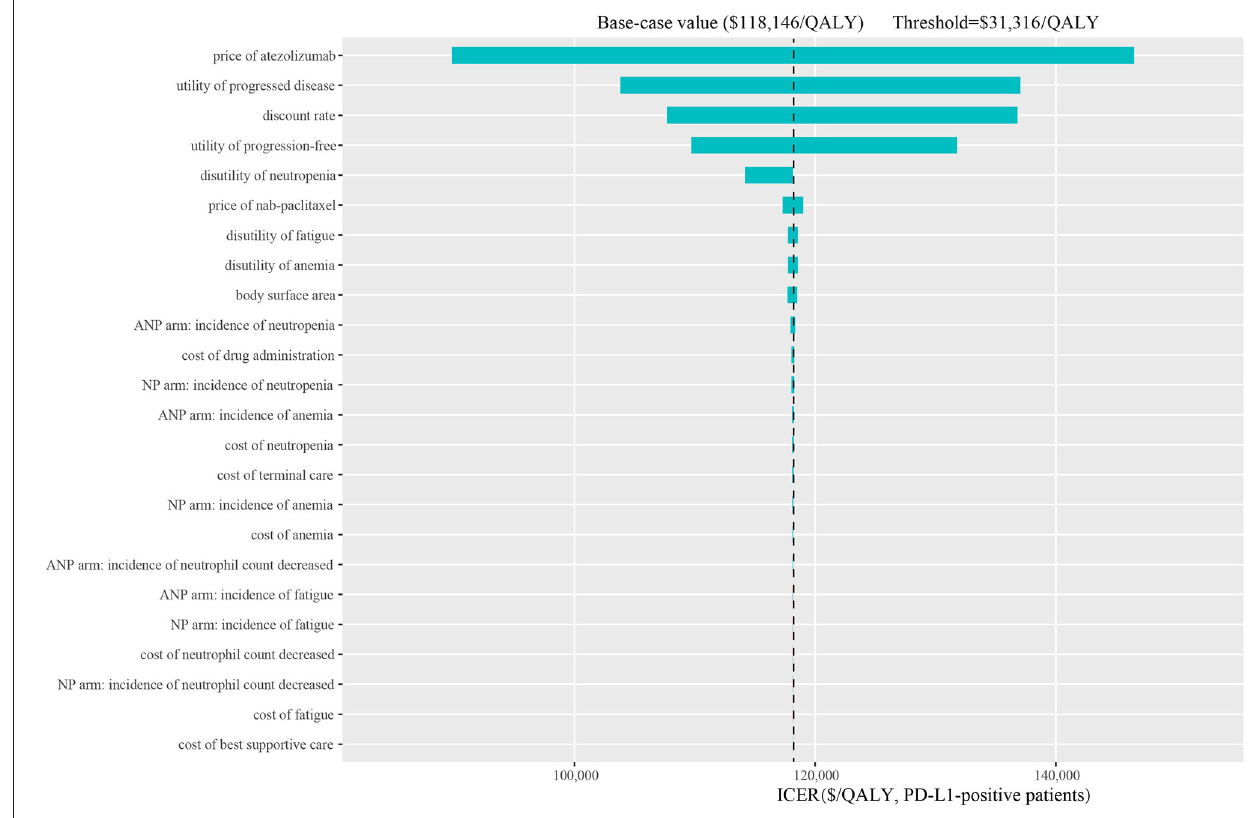
FIGURE 3 | Tornado diagram of one-way sensitivity analysis in the PD-L1-positive patients. ITT, intention-to-treat; PD-L1, programmed death ligand-1; QALY, quality-adjusted life-year; ICER, incremental cost-effectiveness ratio; ANP, atezolizumab plus nab-paclitaxel; NP,